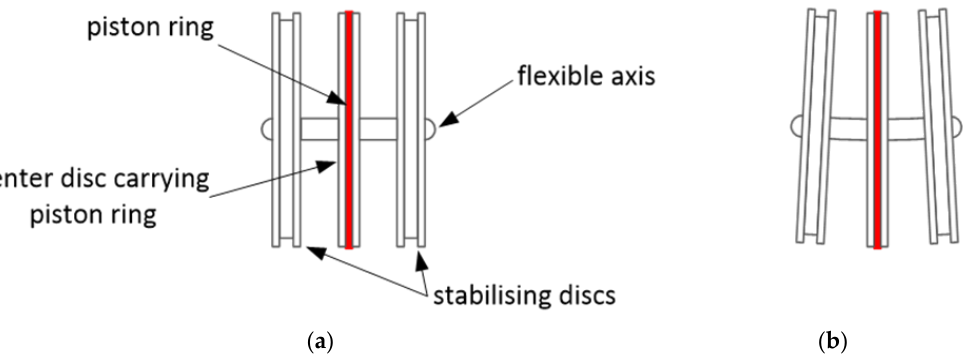
Figure 8. Flexible piston ( a ) with naming of components and ( b ) in bent state.